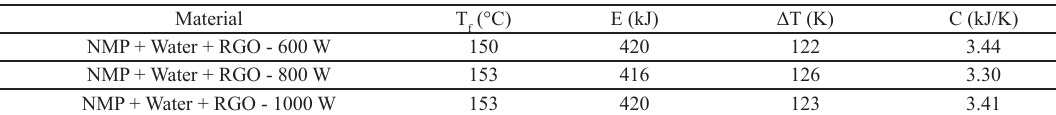
where N is the number of layers, L is the crystallite size 1 002 in the dimension perpendicular to the plane of the graphene sample, d = λ/(2sinθ), with λ = 1.54 nm as the wavelength 002 of the X-ray, and θ is the angle between the incident X-rays and diffracting crystal